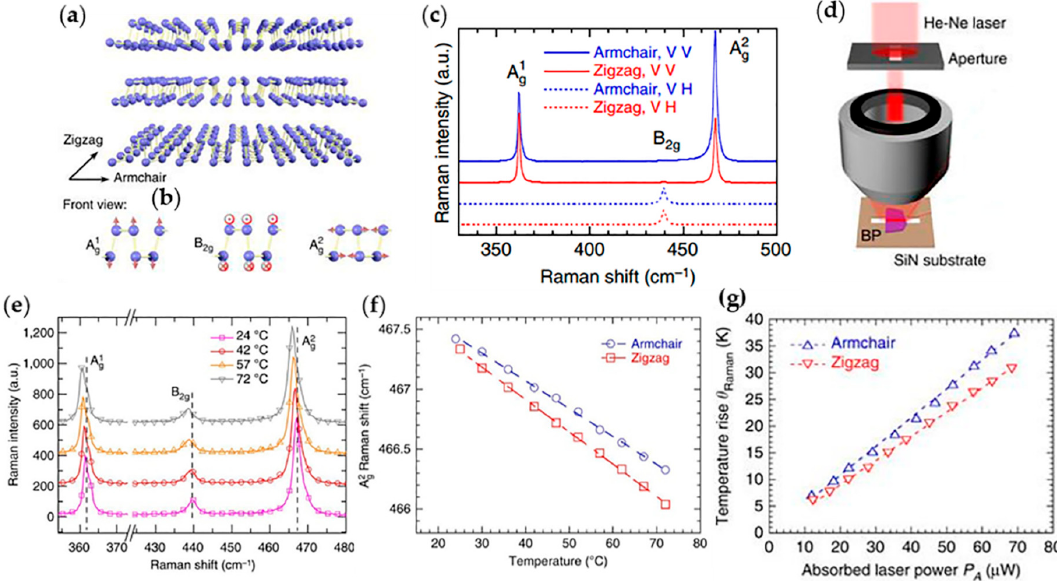
Figure 7. Structure characterization of BP and the process on its thermal conductivity measurements using micro-Raman technique. ( a ) Diagram of the lattice structure of BP. Directions of zigzag and armchair are indicated. ( b ) Atomic vibrational patterns of A g1 , B 2g and A g2 phonon modes from the front view. ( c ) Raman spectra of BP at different directions and vibrational patterns. ‘VV’ and ‘VH’ are two configurations standing for different directions of laser polarization to gain the A g and B 2g vibrational patterns. Zigzag is represented by red lines and armchair is represented by blue lines. ( d ) Illustration of experiment model for measuring suspended BP flakes. Here He-Ne laser through aperture and collecting mirror exposures on the suspended BP laying SiN substrate. ( e ) The Raman spectra of BP flakes at 72, 57, 42 and 24 °C. The three modes of vibration patterns are marked with dashed lines in the diagram so that the Raman shift of them are clearly visible. ( f ) The A g2 Raman shift as a function of temperature under armchair- and zigzag-polarized laser. The fitted straight dash line slopes are the temperature coefficients. ( g ) The temperature rise as a function of absorbed laser power of BP film along armchair and zigzag directions. Reproduced with permission from [109]. Copyright